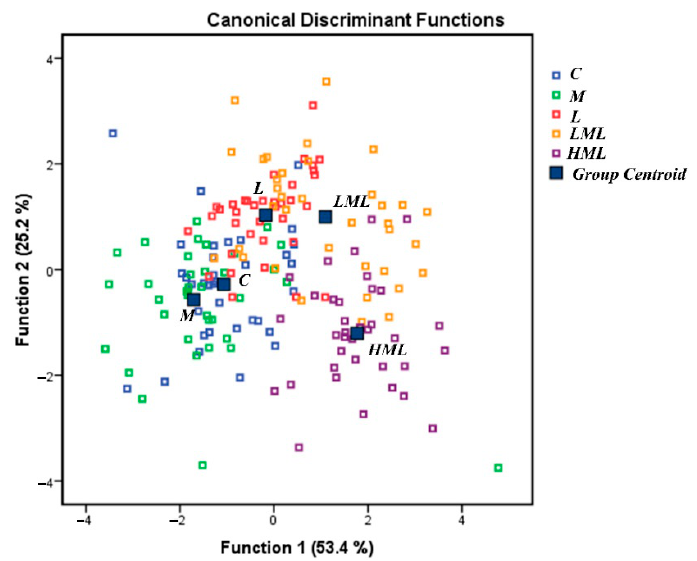
Figure 1. Discriminant plots separating the five dietary treatments (C; blue □ , M; green □ , L; red □ , LML; orange □ , and HML; purple □ ) according to pooled data of three sampling times (25th, 50th, and 75th day) on milk fatty acid profile. Table 3. The mean individual fatty acids (FA) (% of total FA), FA groups, S/U ratio, the AI index, and Δ − 9 desaturase index of ewes’ milk.